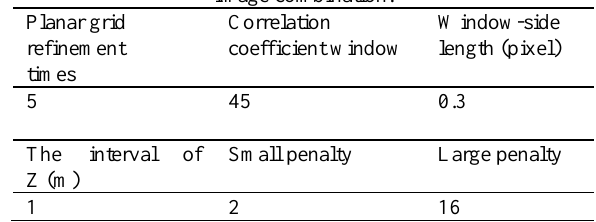
Figure 5. Shaded relief maps of the DEM generated from dual- image combination (a) and three-image combination (b), respectively. both DEMs generated by dual-image combination and three- image